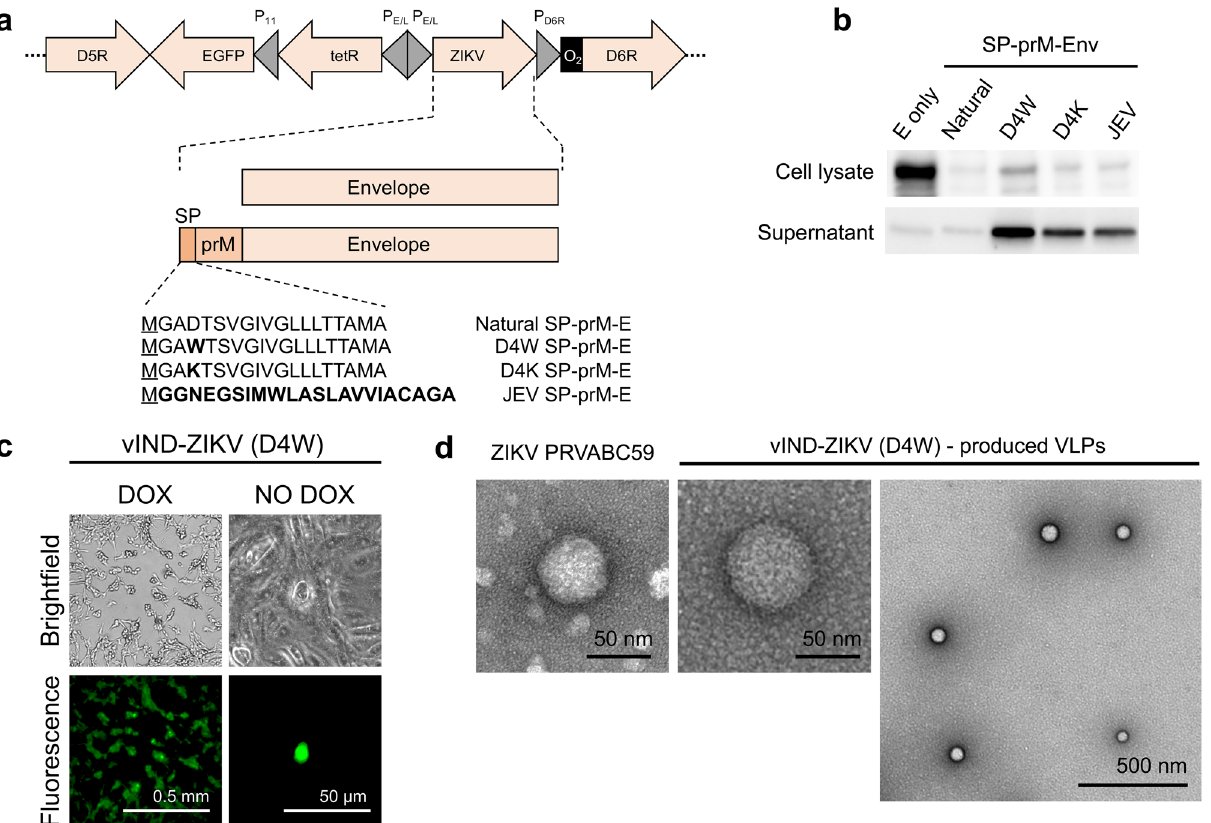
Figure 1. vIND-ZIKV encoding prM and E secretes E into the supernatant of infected cells and forms VLPs. ( a ) Schematic representation of vIND-ZIKV vaccine constructs in the D5R-D6R locus of VACV. Constructs contained the tet repressor gene ( tetR ) under the control of a strong synthetic early/late promoter (P E/L ), the tet operator sequence (O 2 ) immediately downstream of the natural D6R promoter (P D6R ), and the EGFP gene under the control of the natural F17R late promoter (P 11 ). Signal peptide (SP) variant sequences are listed; underlined M represents methionine added to N-terminus and bold amino acids represent mutations from the natural SP sequence or the JEV SP sequence. ( b ) Western blot of Vero cells (lysates or supernatants) infected with the vaccine candidates. Bands of approximately 55 kDa were observed. Full-length blots are presented in Supplementary Figure 3. ( c ) Representative brightfield and fluorescence images of cells 2 days after infection with vIND-ZIKV (D4W), showing plaque formation in the presence of DOX (cytopathic effects on multiple EGFP + cells), or abortive infection (single EGFP + cell) in absence of DOX. ( d ) Representative TEM images of ZIKV PRVABC59 virion (left) or VLPs secreted into the supernatant of vIND-ZIKV (D4W)-infected Vero